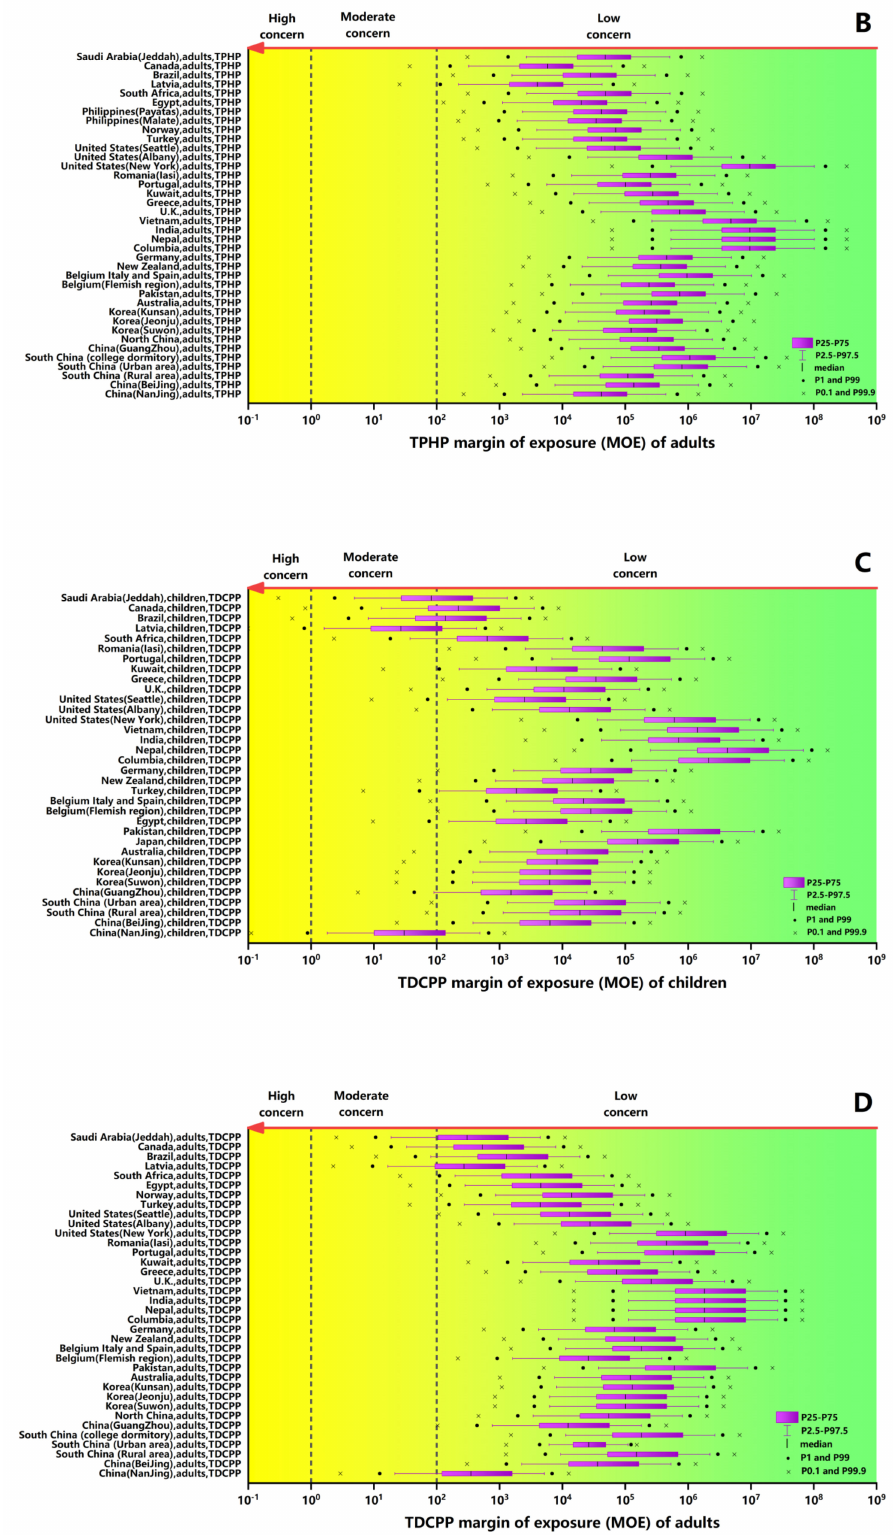
Figure 6. Health risk assessment for children and adults of exposure to TPHP ( A , B ) and TDCPP ( C , D ) via dust ingestion around the world. The descriptions in the Y-axis show the following information: countries/regions, population characteristics and the types of OPEs. The descriptions in the X-axis show the scope of the